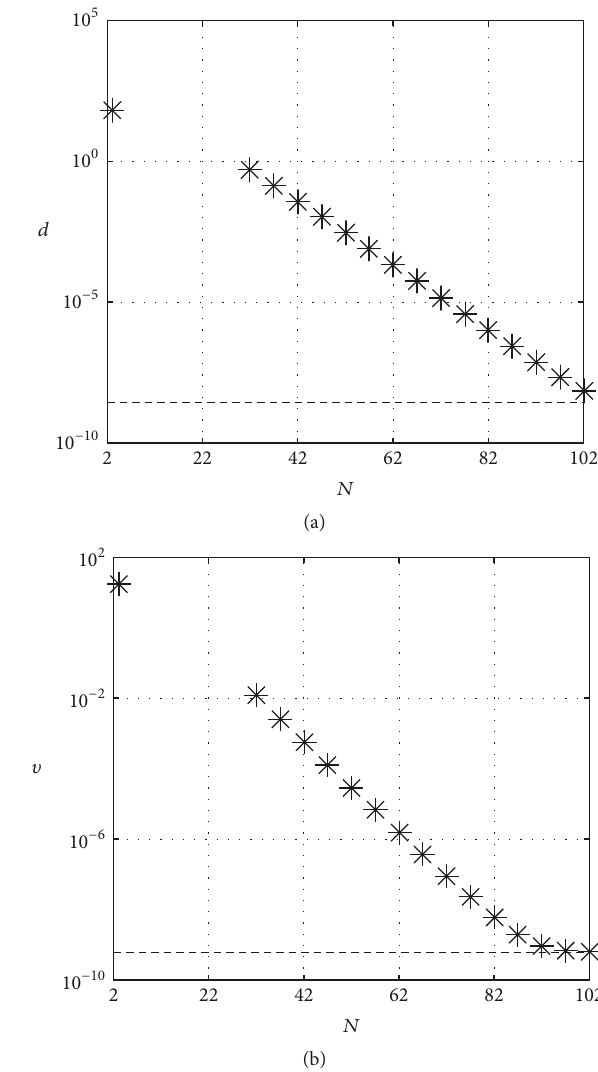
Figure 21: Indexes (a) 𝑑 and (b) 𝜐 when applying aPBC to TUPO4 for different 𝑁 with 𝑘 = 1.85 and 𝑘 𝑜 = 10 . The bottom dashed lines are the values of (a) 𝑑 and (b) 𝜐 computed with 𝑁 = 152 and 𝑘 𝑜 = 50 used as